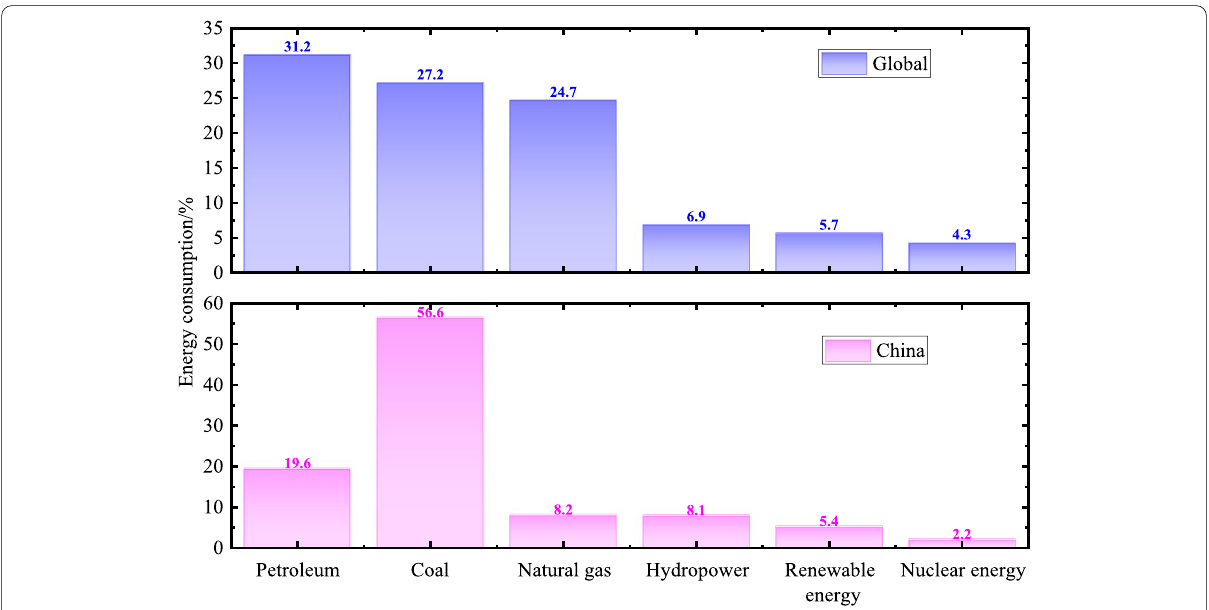
Fig. 1 Global and China’s energy consumption in 2020 [4,